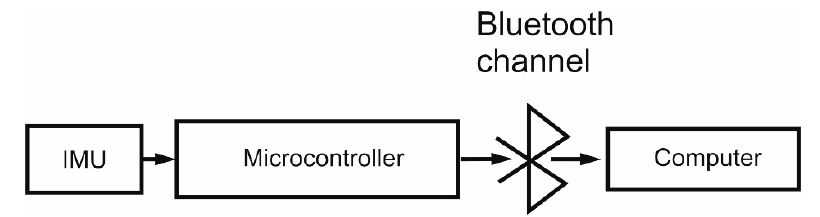
Figure 3. Schematic diagram of the device operation.